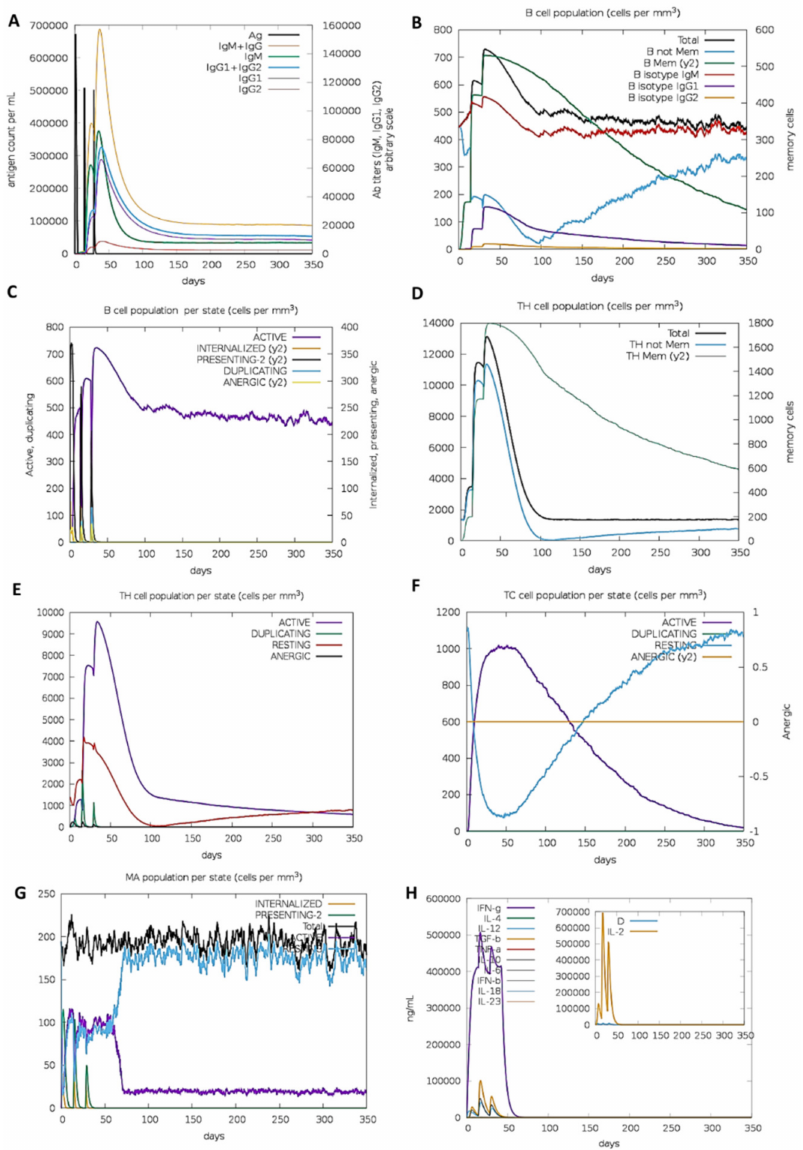
Figure 11. Simulated immune responses generated by the designed construct: ( A ) antibody titers fol- lowing antigen injections; ( B , C ) memory and non-memory B-cell populations, respectively; ( D , E ) TH cell population and population per state, respectively; ( F ) TC cell population per state; ( G ) MA population per state; ( H ) Simpson index “D” and cytokine